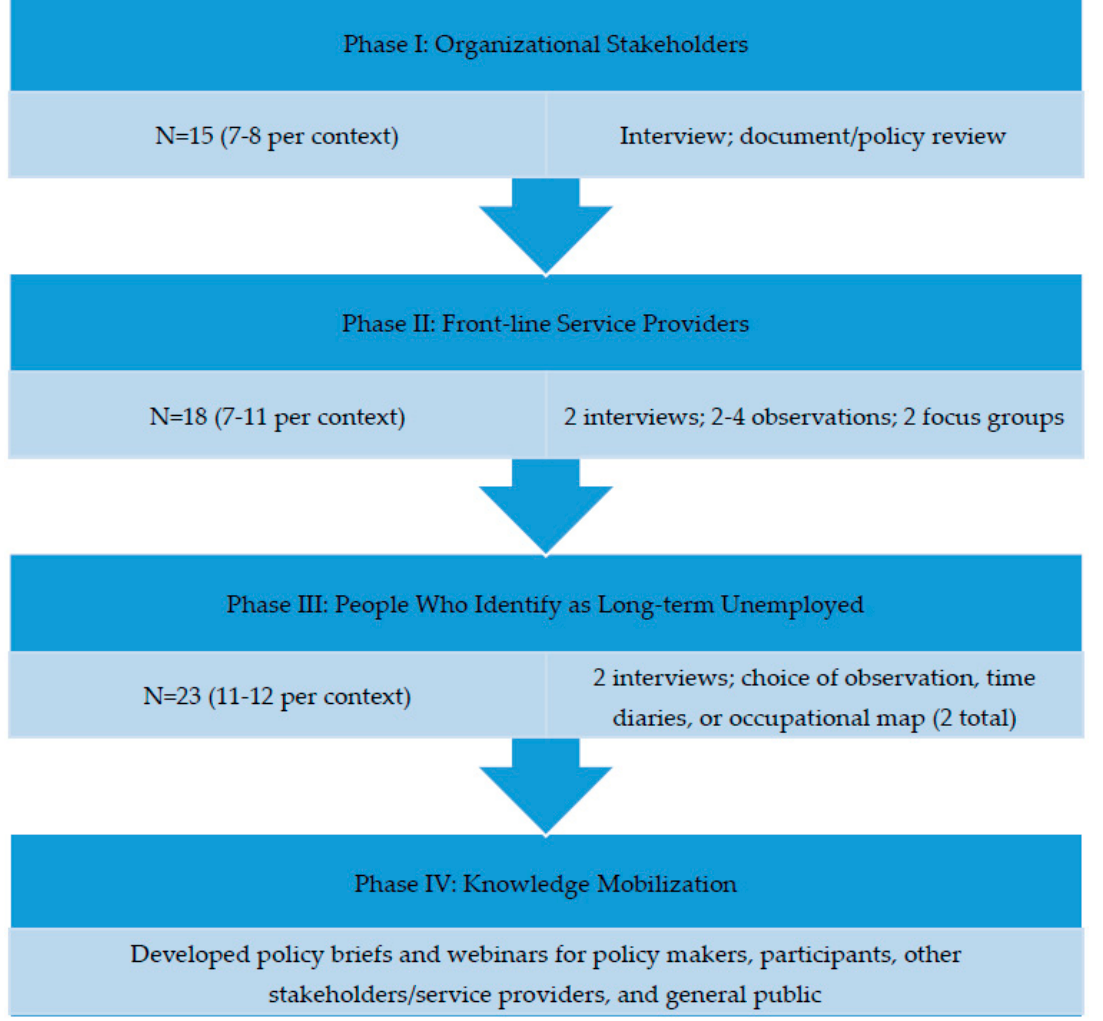
Figure 1. Study Figure 1. Study design.